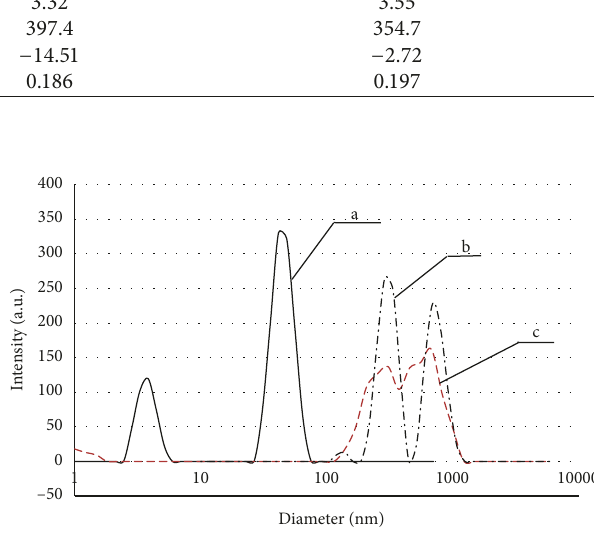
Figure 5: The particle size distribution by intensity of PCE solution (a), MWCNT dispersion (b), and PCE +MWCNT dispersion